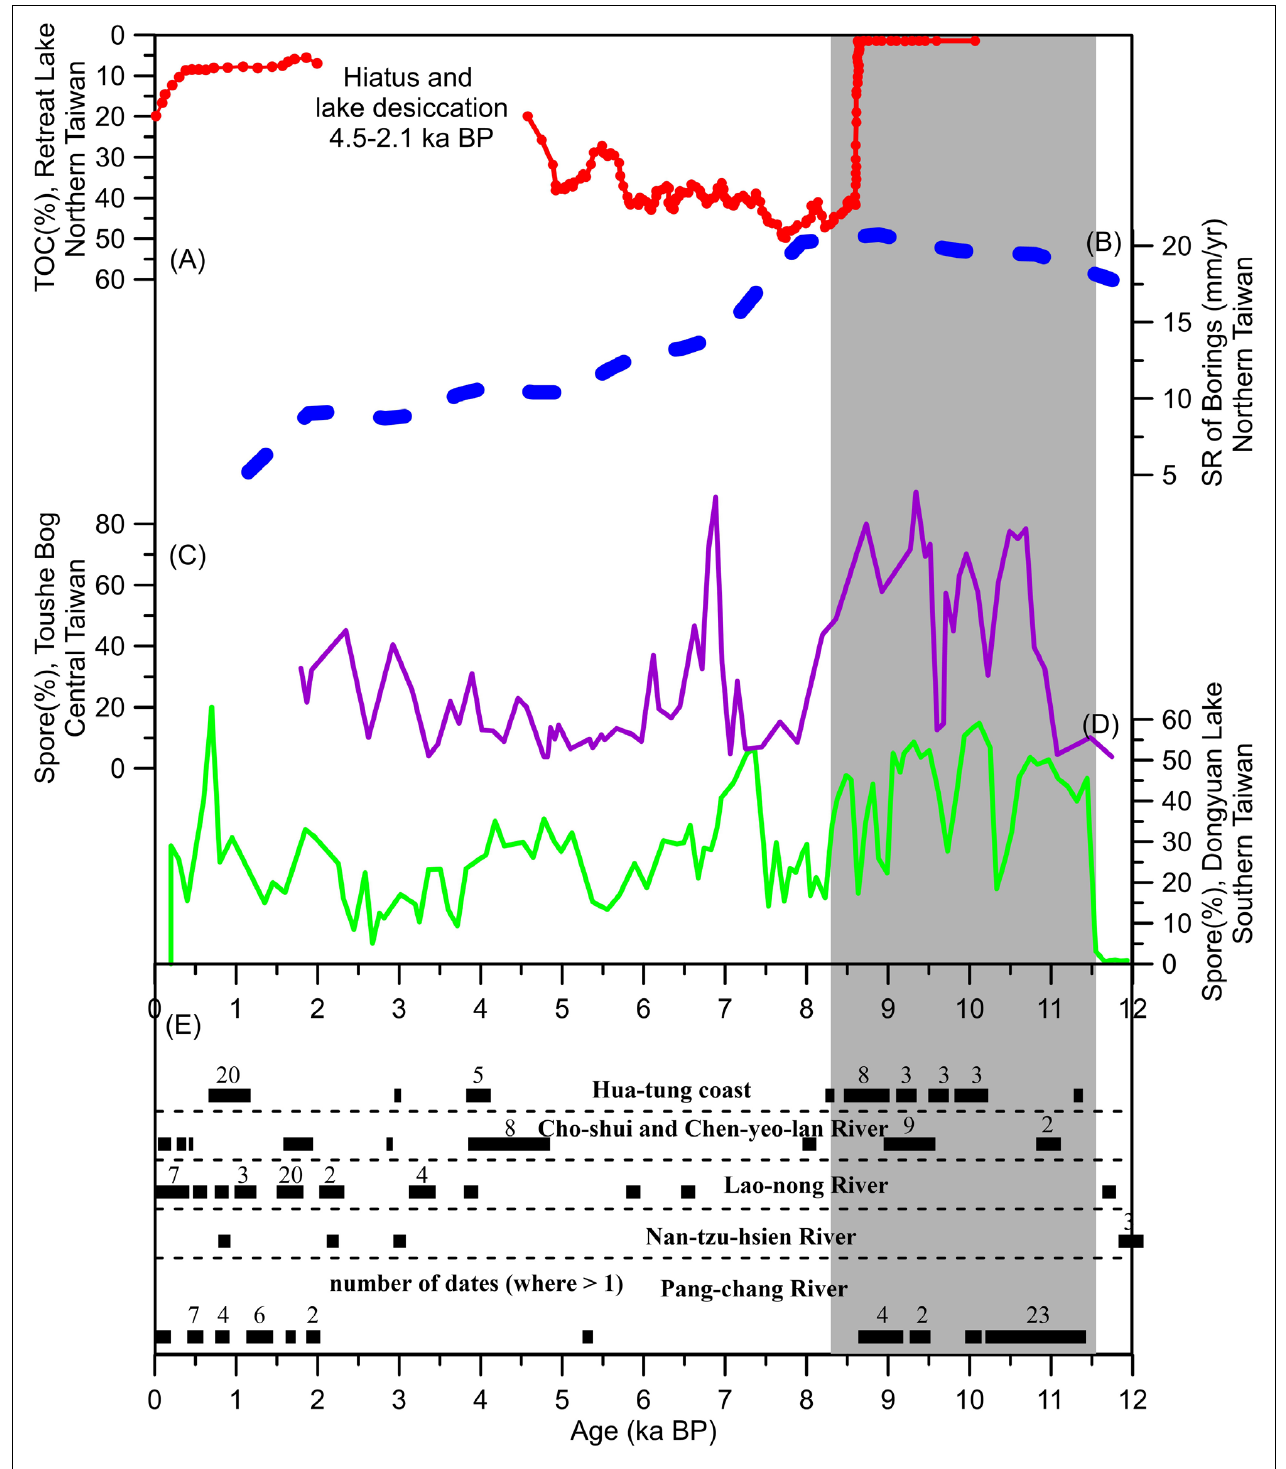
FIGURE 2 | Paleoclimate records from Taiwan. (A) TOC record from Retreat Lake (Selvaraj et al., 2011). (B) Variations in sedimentation rate from on-land cores in northern Taiwan (The blue dashed line, Wu, 2013). (C) Record of spore percentages from Toushe Basin (Liew et al., 2006). (D) Record of spore percentages from Dongyuan Lake (Lee and Liew, 2010). (E) Available radiocarbon dates derived from mass-wasting sequences compiled by Hsieh et al. (2014). Bars represent 1 σ calibrated ranges or their combinations where more than one set of data are available. The numbers ( > 1) of dates are shown above the bars. The gray bar highlights the EASM rainfall maximum during the early